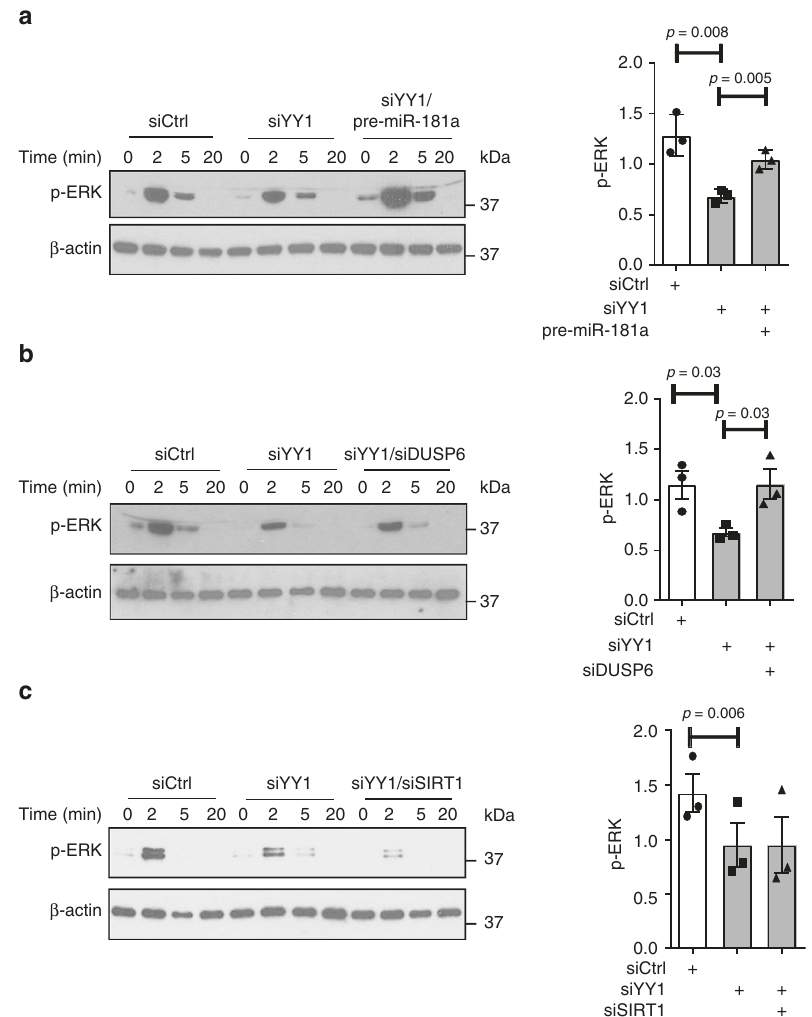
Fig. 5 YY1 regulates T cell receptor signaling through controlling miR-181a expression. Immunoblot analysis of pERK (Thr202/Tyr204) upon CD3/CD28 cross-linking of naive CD4 T cells. Cells were transfected with control siRNA, YY1 siRNA alone (#1 or #2) or YY1 siRNA combined with either pre-miR-181a ( a ), siDUSP6 ( b ) or siSIRT1 ( c ). Results are shown as representative immunoblots (left) and mean ± SEM of pERK relative to β -actin levels at 2 min from one experiment with YY1 siRNA#1 and two experiments with YY1 siRNA#2 (right). All comparisons were done by paired t test ( n =